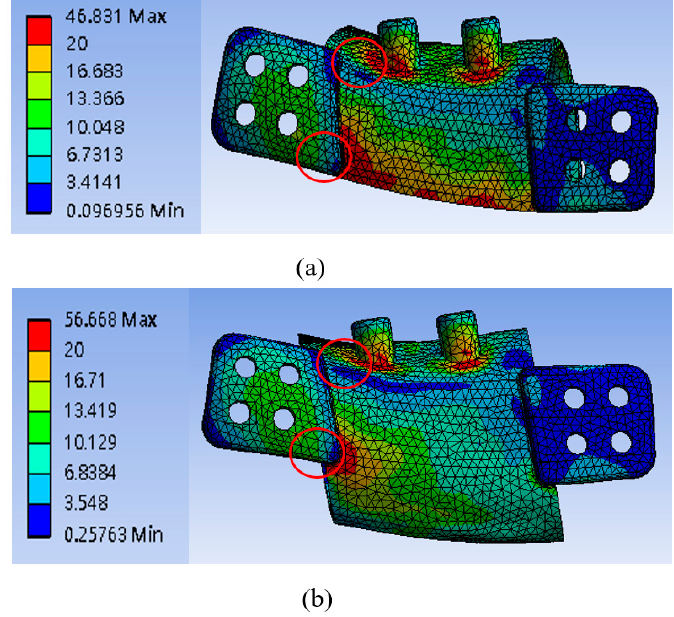
Figure 5. Von Mises stress distribution of the implant: ( a ) Model 1 (length: 20 mm; thickness: 0.8 mm) and ( b ) Model 2 (length: 20 mm; thickness: 0.8 mm) (Unit: MPa). Table 2. High-stress values at different points on the implant body.